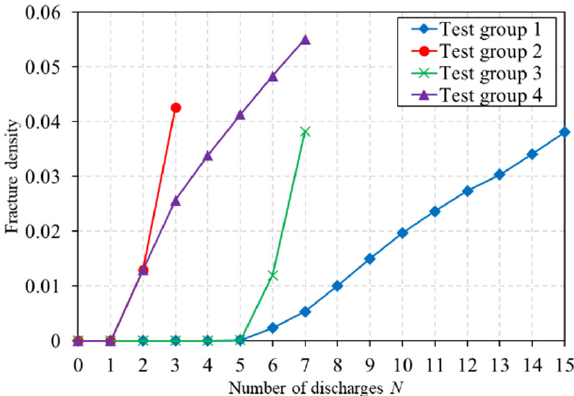
Figure 19. Variation in fracture density under different repetitive loading modes. Table 2. Multi-level discharge energy control loading mode ( P c = 1 MPa and P h = 0 MPa). Test Group